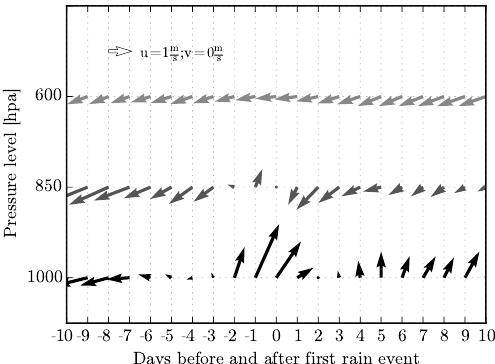
Figure 10. Mean ECMWF wind vectors at three different pressure levels. At the surface, a strong south-westerly wind is blowing the 2 days before the first rain event in the Sahel region followed by northerly winds. At 600hPa winds are constantly from the north-